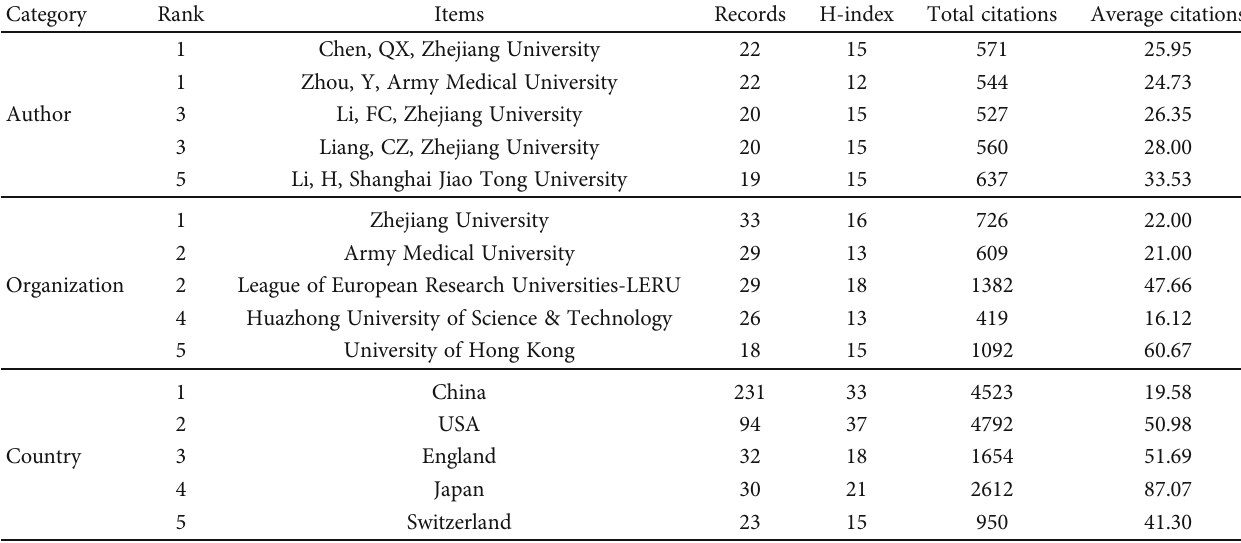
Table 2: The top 5 high-yield authors, organizations, and countries on stem and progenitor cells in intervertebral discs. Category Rank Items